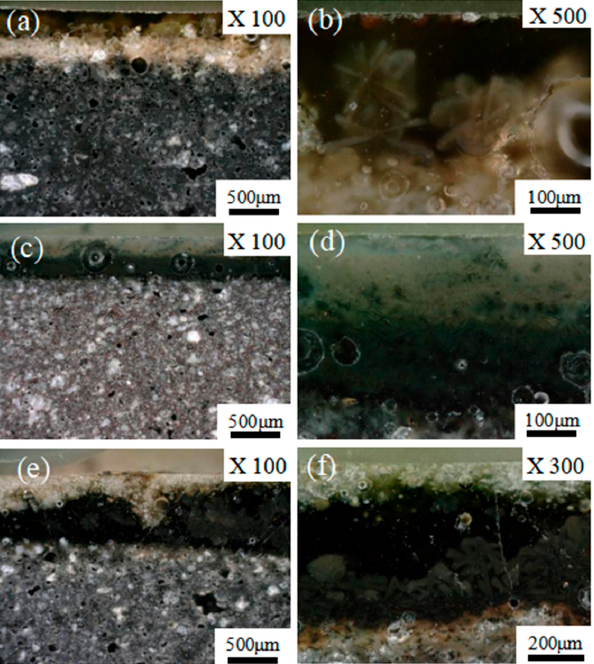
Figure 4. The cross-sections of three analyzed samples: ( a , b ) JZ-07 tea-dust-glazed porcelain; ( c , d ) JZ-16 grey-glazed porcelain; and ( e , f ) JZ-14 pearl-glazed porcelain.